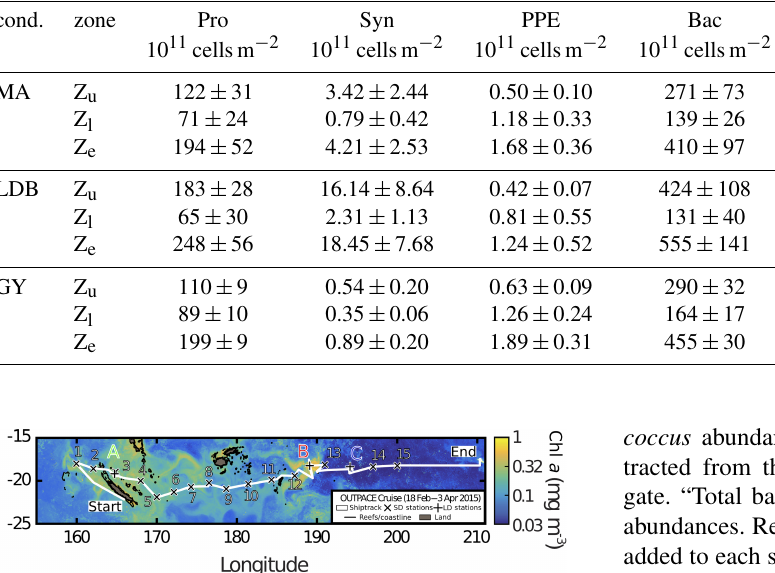
Figure 1. Quasi-Lagrangian surface chlorophyll- a concentration (mgm − 3 ) in the sampling region. Data represent the mean chlorophyll- a concentration in March 2015. The white line iden- tifies the track of the OUTPACE cruise, with the sampled stations marked 1 to 15 (x) and the long-duration stations marked A, B and C ( +